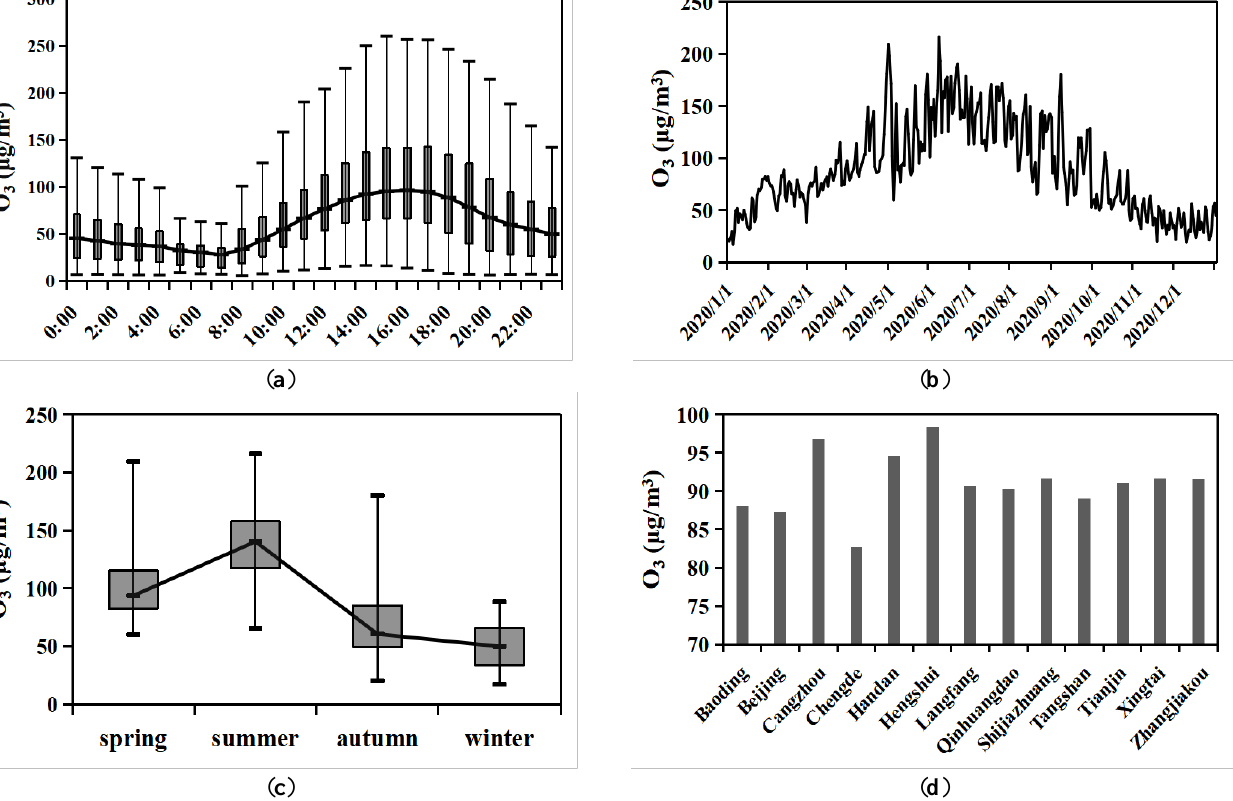
Figure 2. Variation characteristics of observed O 3 concentrations in 2020. ( a ) hourly O 3 concentration, ( b ) daily maximum 8-h average O 3 concentration, ( c ) seasonal maximum 8-h average O 3 concentration, and ( d ) annual maximum 8-h average O 3 concentration in different cities.